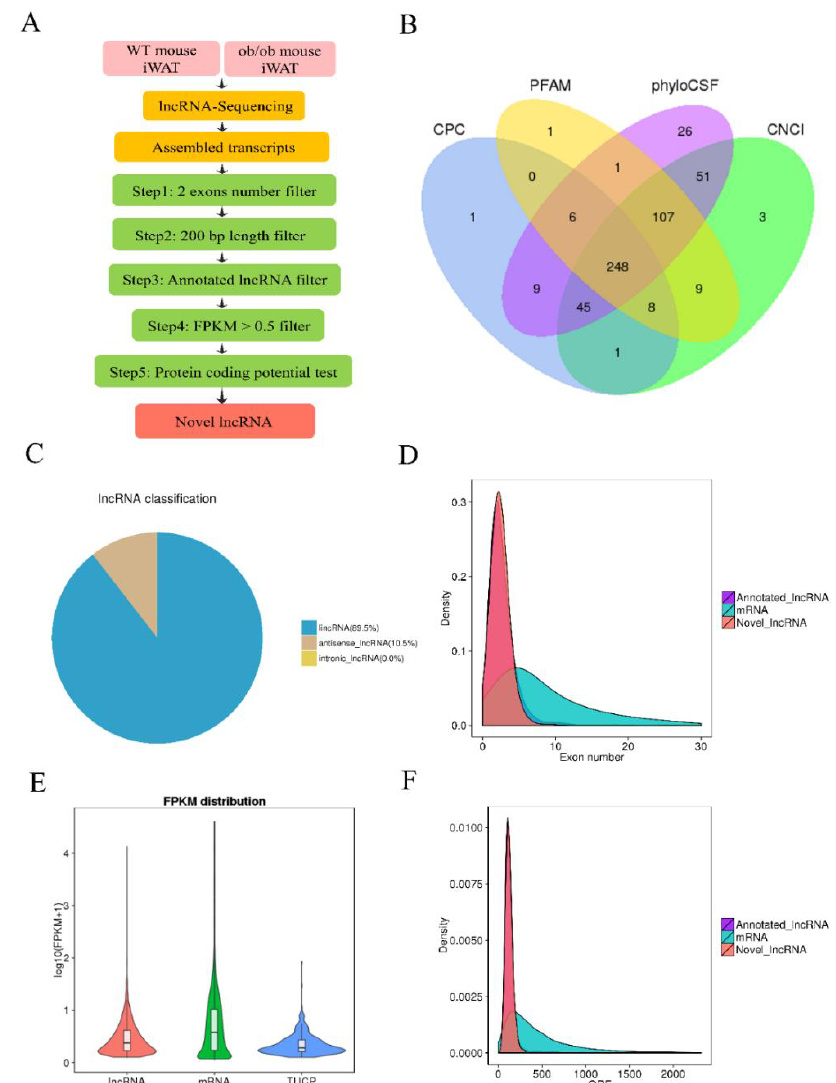
Figure 1. Identification and characterization of long noncoding RNAs (lncRNAs) in wild-type (WT) and ob / ob mice. ( A ) Flow chart of novel lncRNAs identification in WT and ob / ob mice. ( B ) Venn diagram of coding potential analysis by the coding potential calculator (CPC), the Pfam Scan, phylogenetic codon substitution frequency (phyloCSF), and the coding–non-coding index (CNCI). ( C ) Pie charts of the lncRNA classification, including lincRNA, antisense lncRNA, and intronic lncRNA. ( D ) Density of transcript exon number. ( E ) Fragments Per Kilobase of transcript per Million fragments mapped (FPKM) reads distribution of transcripts. ( F ) Open reading frame (ORF) length of transcripts. iWAT: inguinal white adipose tissue.